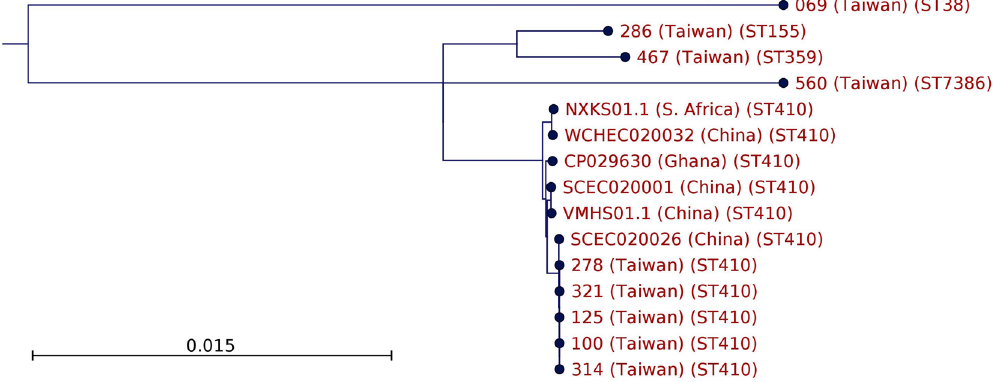
Figure 3. Core genome MLST analysis result based on the whole genome sequencing data on the chromosome of ST410.